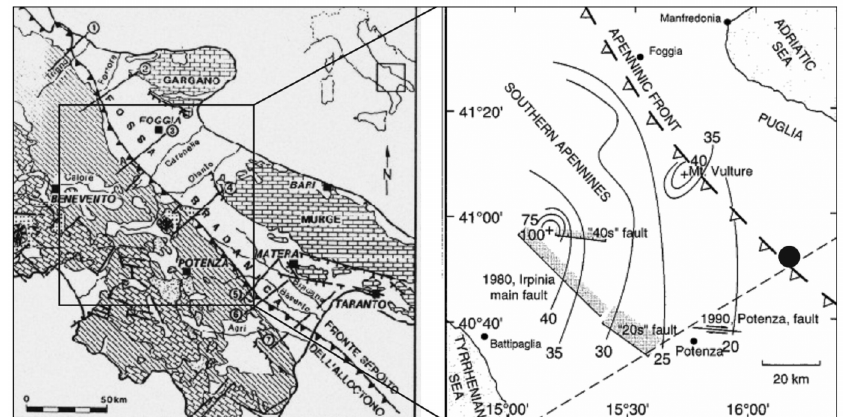
Fig. 5a,b. a) Geological scketch of Southern Italy (from Sella et al. , 1988); b) map of the thermal gradient of Southern Appennines in °C/km, the black dot is the investigated area. The «40s» and «20s» represent two faults described in Doglioni et al. (1996).